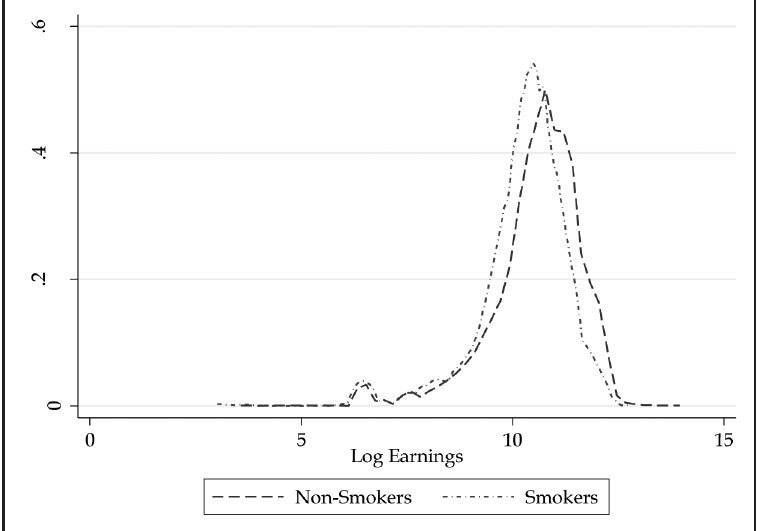
Log earnings of smokers versus